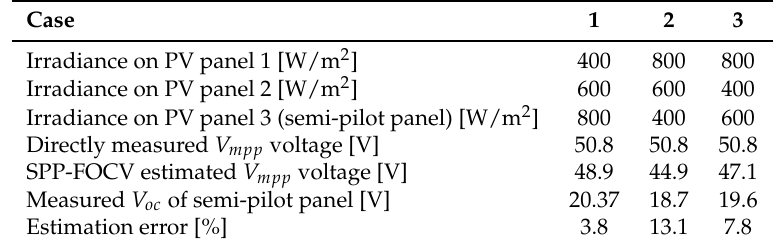
Table 11. Experimental comparison between directly measured and SPP-FOCV estimated V mpp voltage under partial shading conditions. The temperature of the PV cells is 25 ◦